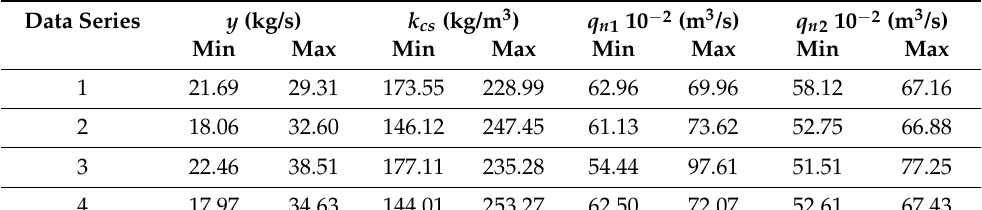
Table 1. The range of variations of solids flow rate, solids contraction, and feed flow rate to the flotation process.